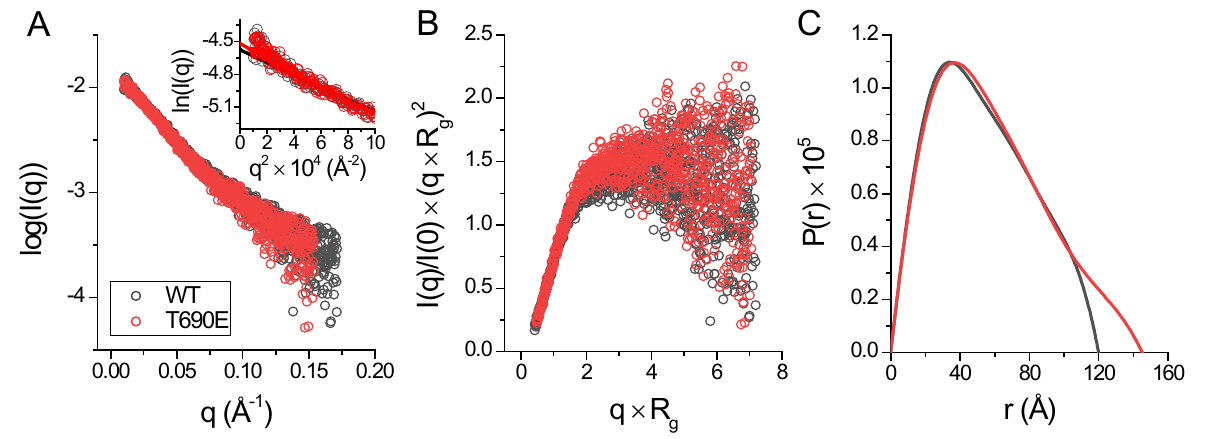
Figure 6. ( A ) X-ray scattering profile of Hs Hk183 (black colored) and Hs Hk183 T690E (red colored) in solution. The Guinier plot is shown in the insert. ( B ) Normalized Kratky plot for subjected samples is characteristic for partially unfolded or rod-shaped proteins. ( C ) Pair distance distribution P(r) function of Hs Hk183 (black colored) and Hs Hk183 T690E (red colored) is characteristic for rod-shaped particles [34].